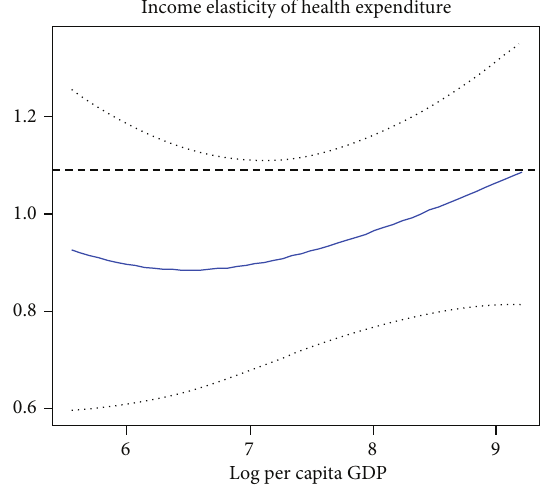
Figure 3: The income elasticity estimator of middle income African countries,thesolidcurvesrepresents 𝑚 󸀠 ( lnGDP ) . Thedottedcurves correspond to its 95% confidence interval. The level dashed line represents the estimate from the linear